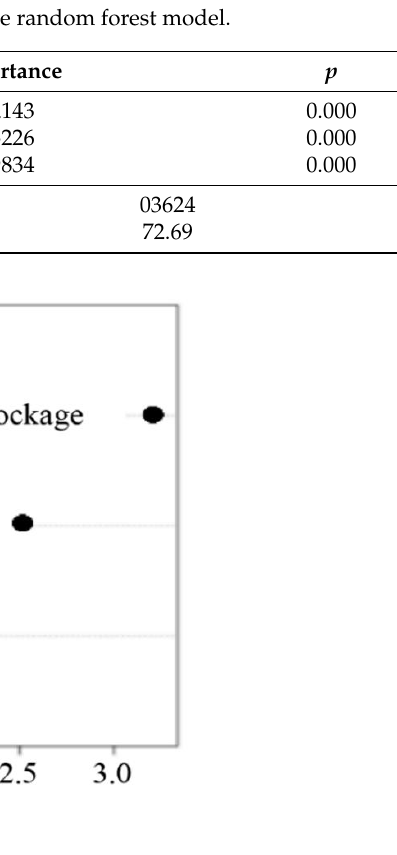
Figure 16. Variable importance.